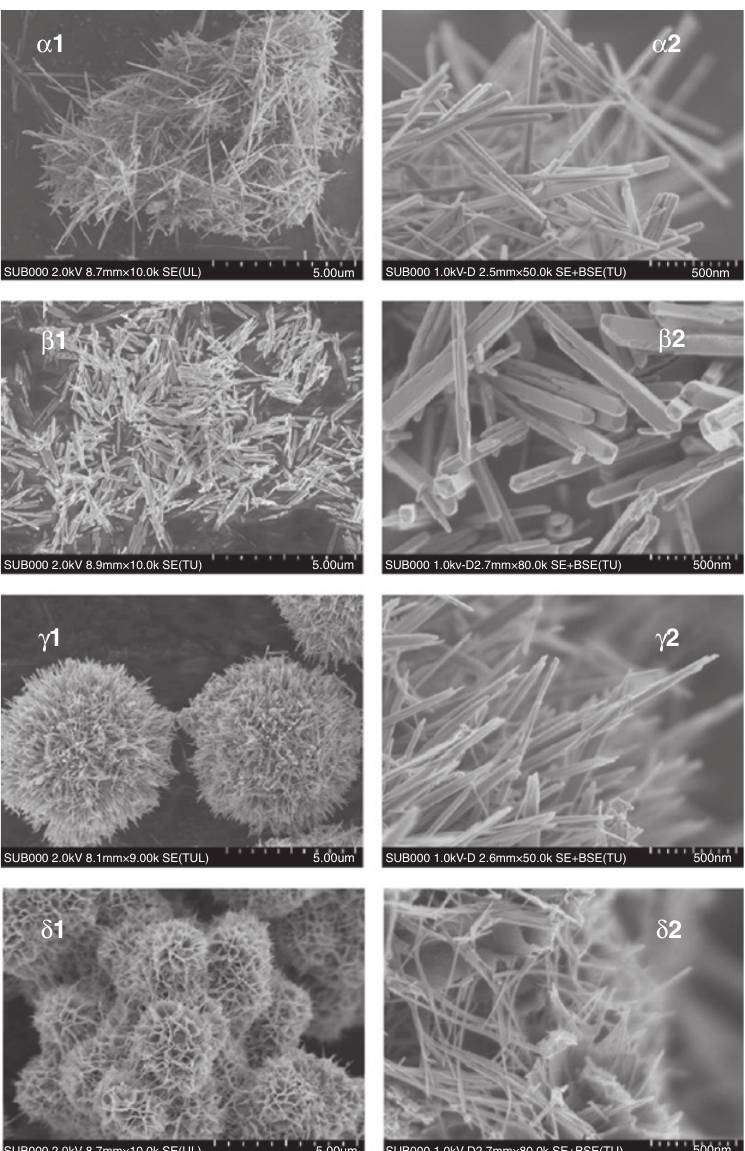
samples; 1 and 2 refer to different magnifications of one sample. Reproduced from [69] 2